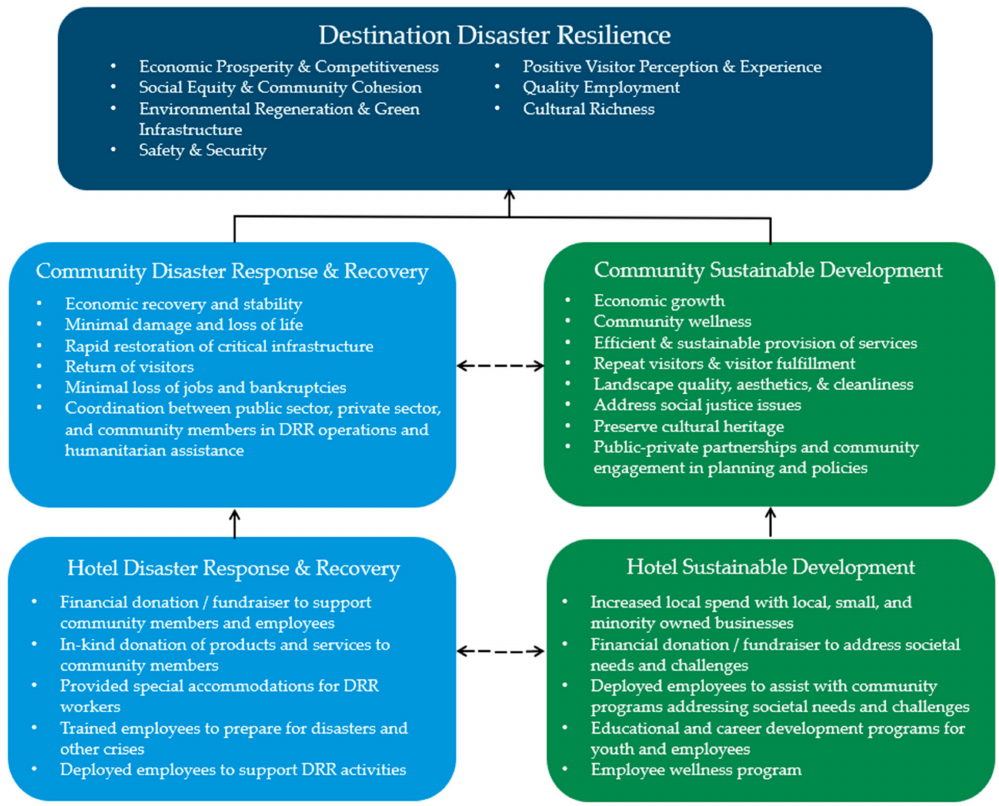
Figure 7. Demonstrating the convergence between disaster relief and sustainable development for destination resilience, as well as the relationship between community and hotel